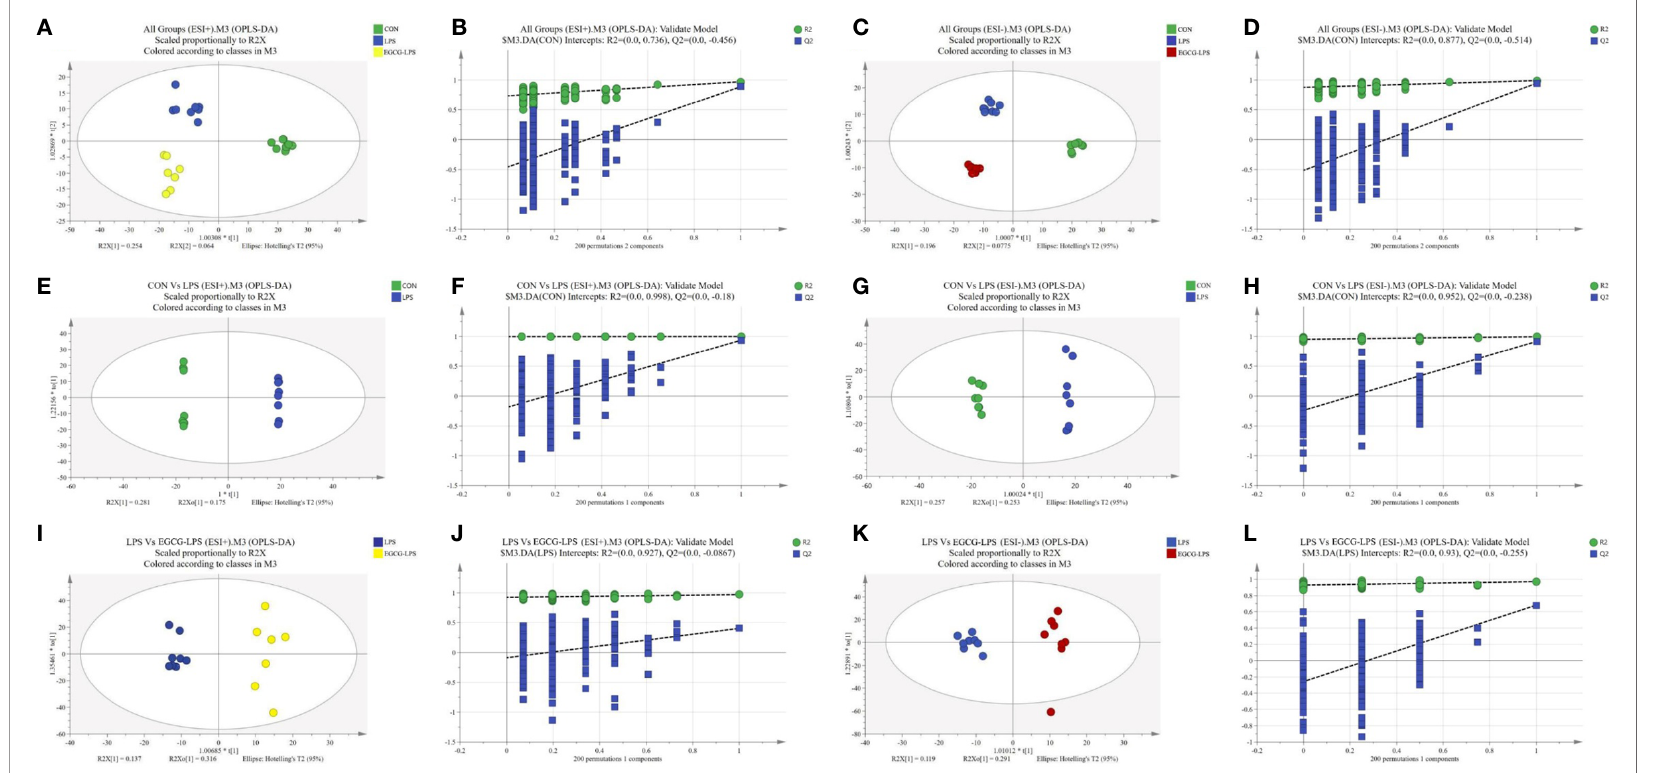
FIGURE 7 | Plots of the multivariate statistical comparisons between groups. (A) OPLS-DA score plot of all groups (ESI+); (B) OPLS-DA (Validate Model) score plot of all groups (ESI+); (C) OPLS-DA score plot of all groups (ESI-); (D) OPLS-DA (Validate Model) score plot of all groups (ESI-); (E) OPLS-DA score plot of CON Vs LPS (ESI+); (F) OPLS-DA (Validate Model) score plot of CON Vs LPS (ESI+); (G) OPLS-DA score plot of CON Vs LPS (ESI-); (H) OPLS-DA (Validate Model) score plot of CON Vs LPS (ESI-); (I) OPLS-DA score plot of LPS Vs LPS-EGCG (ESI+); (J) OPLS-DA (Validate Model) score plot of LPS Vs LPS-EGCG (ESI+); (K) OPLS-DA score plot of LPS Vs LPS-EGCG (ESI-); (L) OPLS-DA (Validate Model) score plot of LPS Vs LPS-EGCG